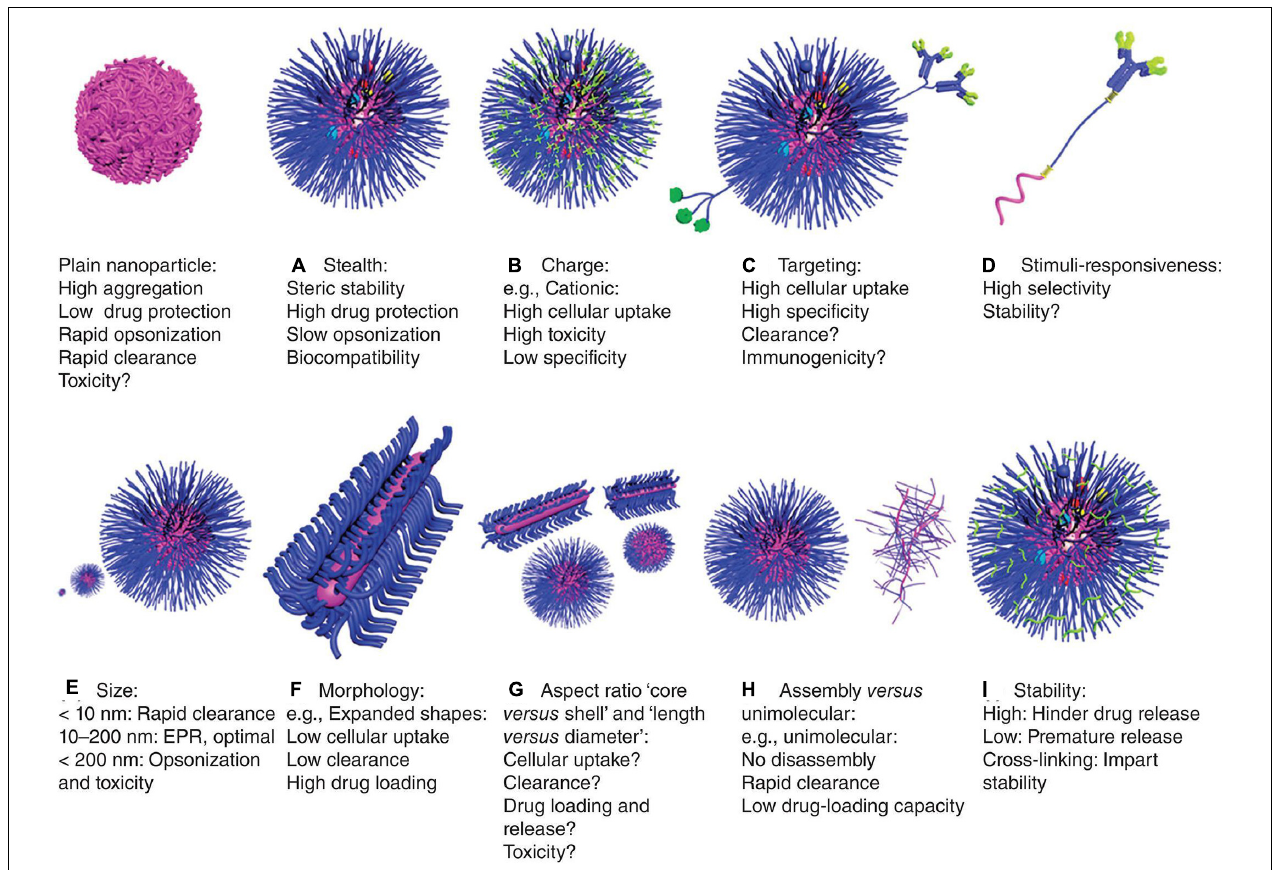
FIGURE 4 | Characteristics of polymeric nanoparticles (Elsabahy and Wooley, 2012). The characteristics of polymer nanoparticles have great impact on their behavior in vitro and in vivo , including: (A) stealth: they have biocompatibility and stability, encapsulating drugs, which protect the nanoparticles from clearance by cells, but it may also reduce cell uptake and endosomal escape, (B) charge: cationic property can enhance cell uptake and endosomal escape, but their tissue distribution and toxicity are uncontrolled, (C) targeting: they have enhanced cellular uptake and specificity, but sometimes with accelerated clearance and/or immunogenicity, (D) stimuli-responsiveness: they can release drugs selectively at specific sites, but the stability and responsiveness of the materials may differ in physiological and pathological conditions, leading to premature drug release, (E) size: a size of about 100 nm is optimal for drug delivery, which is large enough to avoid being cleared by the kidneys, and small enough to reduce cell clearance and toxicity, (F) morphology: expanded morphology improves drug-loading capacity and reduces cellular uptake and clearance, (G) aspect ratio: the volume, length and diameter ratio of shell vs. core can greatly affect drug delivery efficiency and toxicity, (H) assembly vs. unimolecular structures: unimolecular structures are relatively more stable, but have poor drug-loading capacity and can be easily cleared, and (I) stability: stability of nanoparticles in circulation and physiological barriers and release at specific sites can be achieved by means of